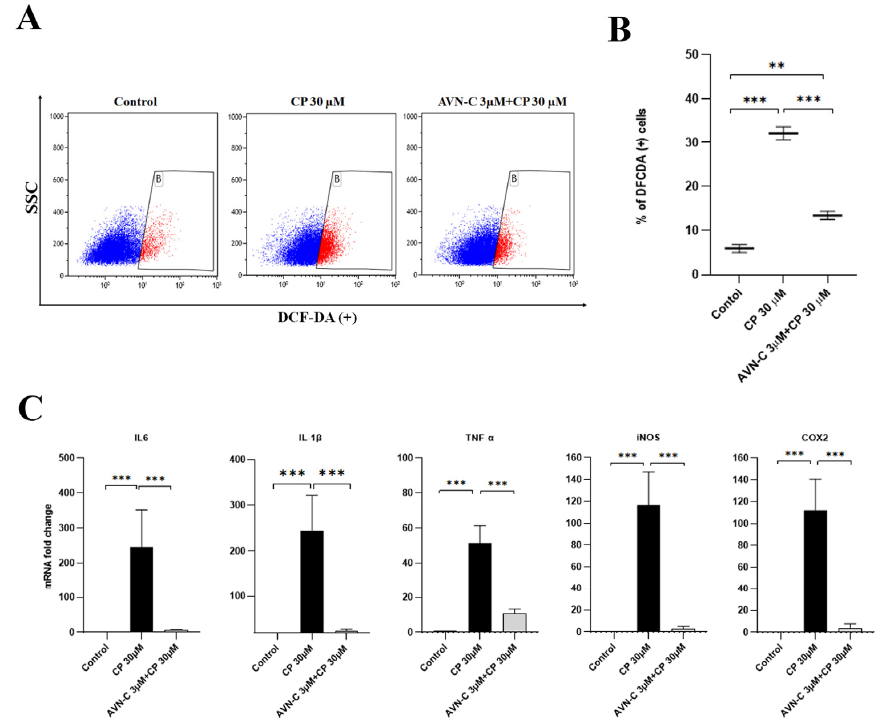
Figure 5. AVN-C reduces apoptotic bodies in CP-induced ototoxicity in HEI-OC1 cells. ( A , B ) ROS significantly increased when 30 µm CP was administered to HEI-OC1 cells (*** p ≤ 0.001, Control vs. CP and AVN-C vs. CP; ** p ≤ 0.01, Control vs. AVN-C+CP ) and AVN-C mitigated CP cytotoxicity by protecting the HEI-OC1 cells against CP-induced damage (*** p ≤ 0.001; n = 3 each). Demarcated (B) area in red shows DCFDA positive. ( C ) The levels of inflammatory cytokines (IL6, IL-1 β , TNF- α , iNOS , and COX2 ) that are known to trigger inflammation of auditory hair cell death were all upregulated in the CP-treated group (*** p ≤ 0.001, Control vs. CP), and AVN-C significantly downregulated the expression of these genes (*** p ≤ 0.001, AVN-C vs. CP; n = 3 each). One way- ANOVA was used and p ≤ 0.05 indicated significance. 2.6. AVN-C Alleviates Cisplatin-Induced Inflammation in HEI-OC1 Cells Based on the alterations in the inflammatory cytokine expression patterns, qualitative real-time polymerase chain reaction (RT-PCR) was used to better understand the downstream signaling pathways of AVN-C and CP. When the experiment was repeated, CP increased the expression of all the inflammatory genes that were examined ( IL6 , IL-1 β , TNF- α , iNOS , and COX2 ). AVN-C pretreatment before introducing CP to HEI-OC1 cells appeared to considerably reduce inflammation by decreasing the expression of these genes (IL6, IL-1 β , TNF- α , iNOS , and COX2 ) (Figure 5C). The experiment was repeated three times and p ≤ 0.05 was found to be significant in all groups that were compared. 2.7. AVN-C Inhibits Cisplatin-Induced DNA Damage Immunofluorescence time-dependent phosphorylated H2AX levels related to AVN-C and CP exposure at various time points. At 24 h after exposure to HEI-OC1 cells, the intensity of H2AX fluorescence in AVN-C- exclusively treated cells was equal to that of non-treated cells, with a 1-fold increase in cells and a small number of low nuclear H2AX foci. Three hours after CP addition, cells displayed varied nuclear H2AX phosphorylation patterns that were clearly visible in the AVN-C-treated group, along with a 1.4-fold increase (Figure 6A,B). CP induced a rapid